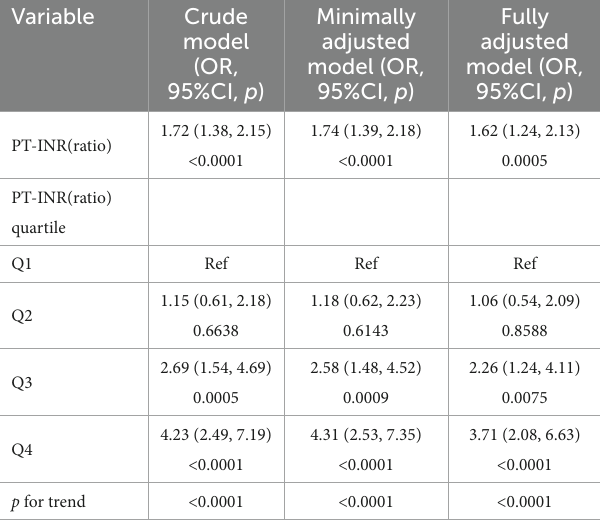
Table 1 were modified. OR: Odds ratio; CI: confidence interval; Ref: reference.